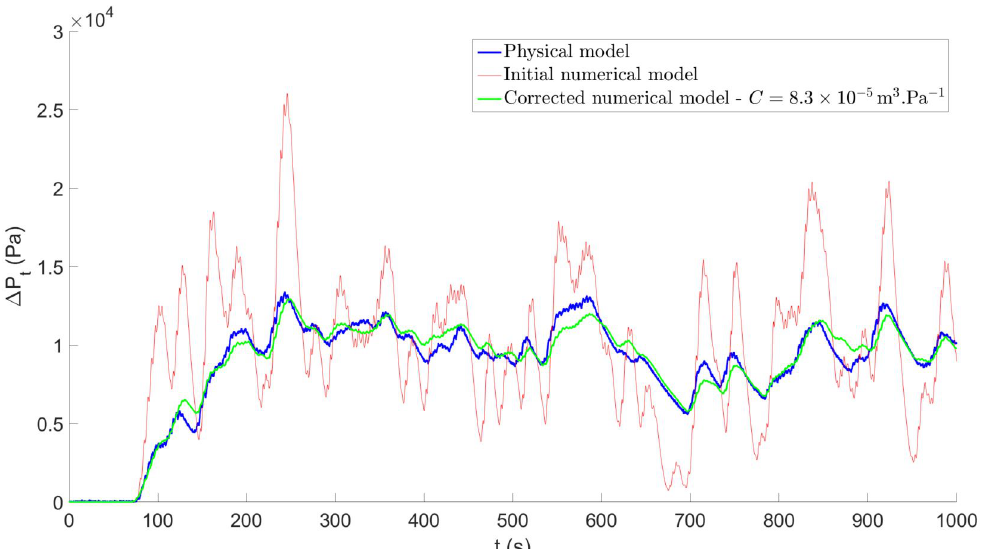
Figure 12. Pressure drop time series across Orifice 3 of the Tupperwave device obtained by the physical model, the initial numerical model, and the corrected model in the irregular sea state { H s = 3 m; T p = 8.5